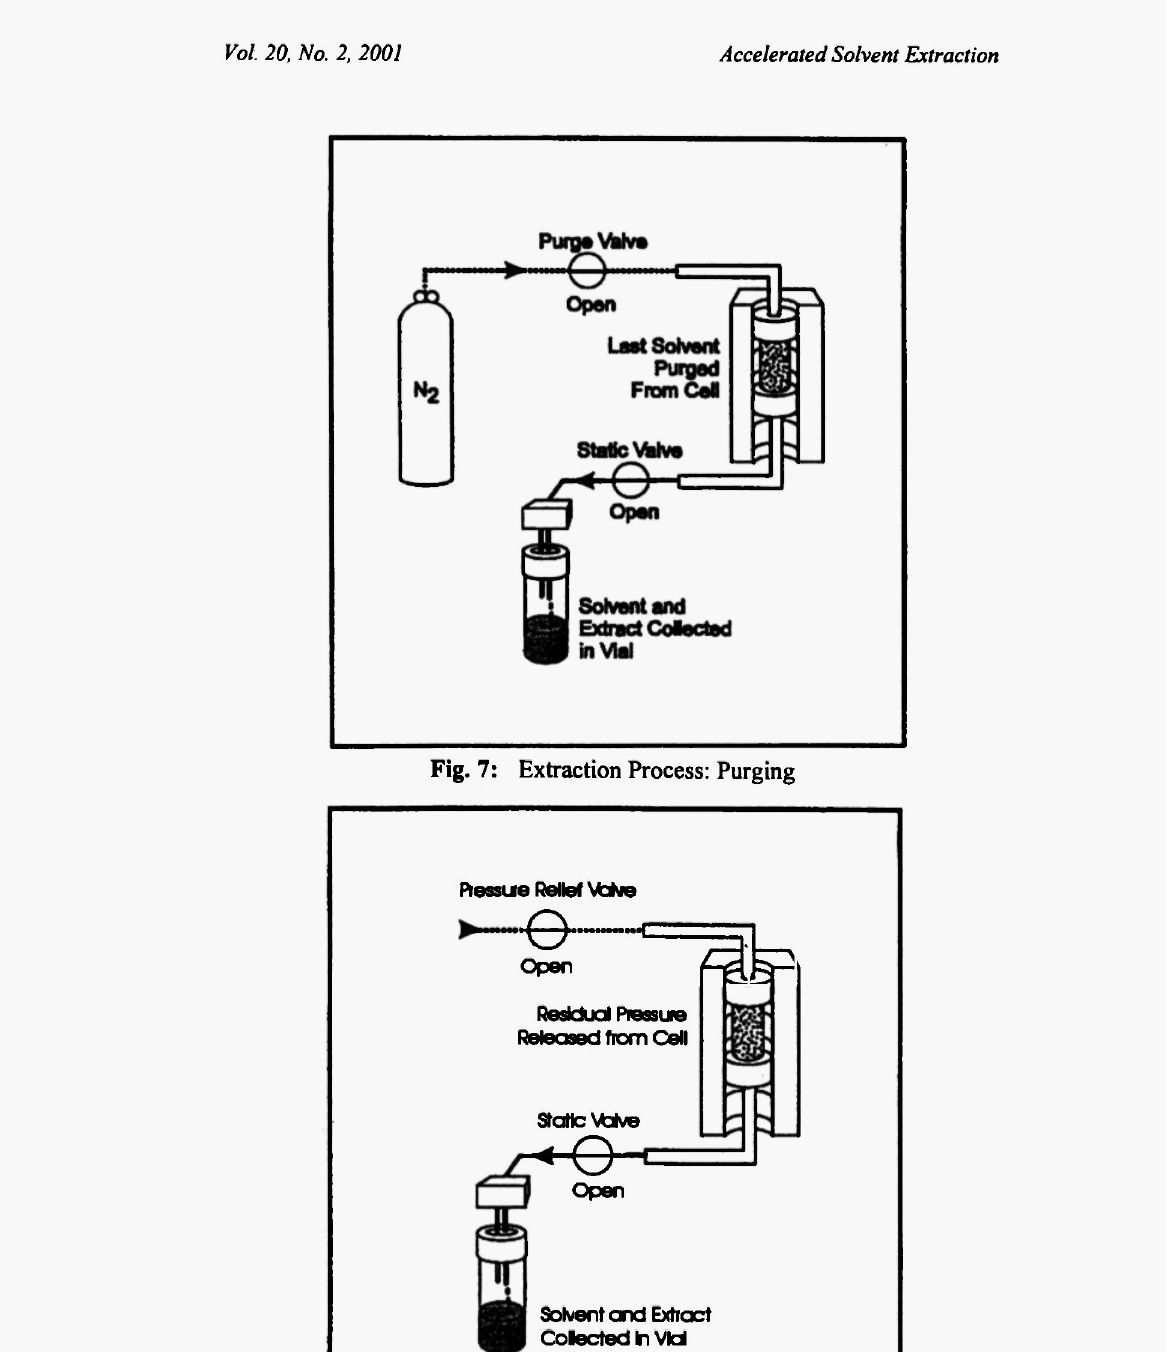
Fig. 8: Extraction Process: End